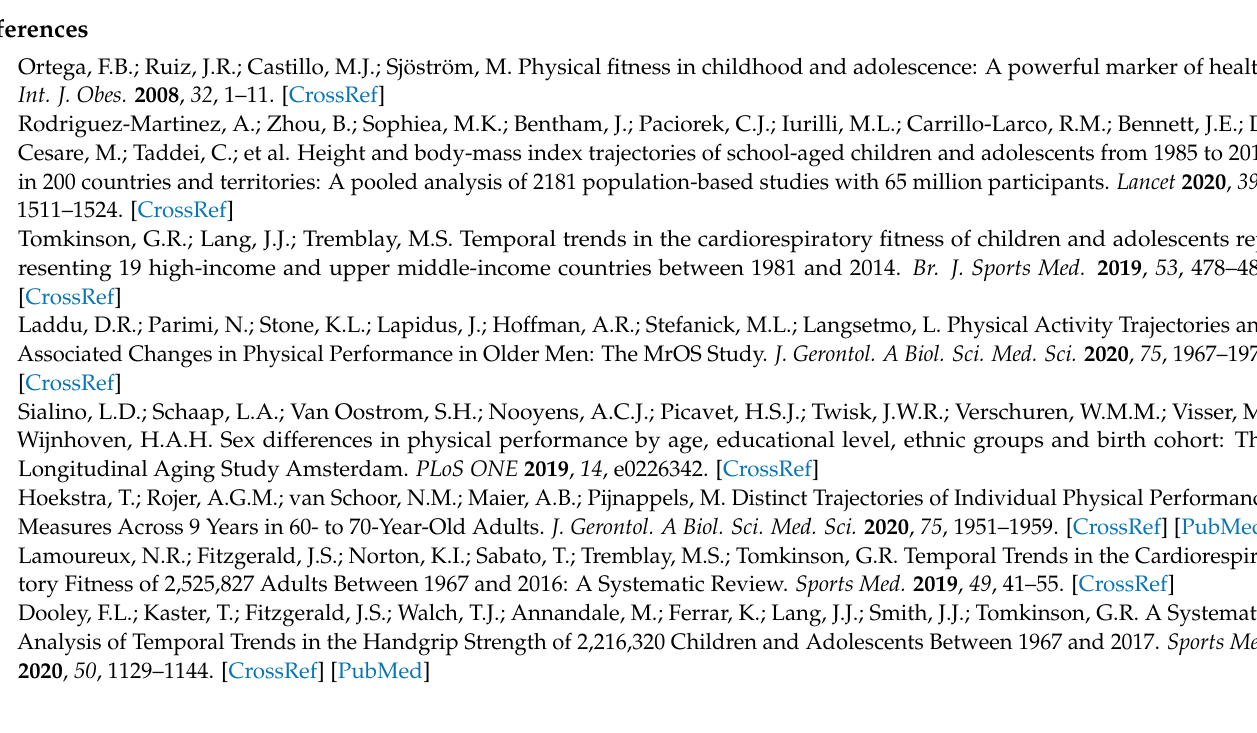
Table S9: Pearson’s chi-squared ( χ 2 ). Association between the samples assessed (prepandemic and pandemic) and distribution regarding standing long jump cut points for boys; Table S10: Pearson’s chi-squared ( χ 2 ). Association between the samples assessed (prepandemic and pandemic) and dis- tribution regarding standing long jump cut points for girls; Table S11: Pearson’s chi-squared ( χ 2 ). Association between the samples assessed (prepandemic and pandemic) and distribution regarding 20 m shuttle run test cut points for boys; Table S12: Pearson’s chi-squared ( χ 2 ). Association between the samples assessed (prepandemic and pandemic) and distribution regarding 20 m shuttle run test cut points for